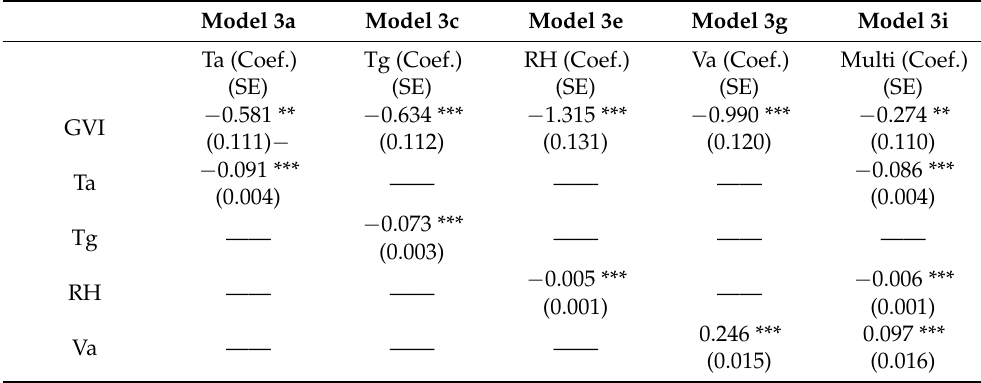
Table 4. Results of the mediating effect of microclimatic parameters on the greenery–TCV